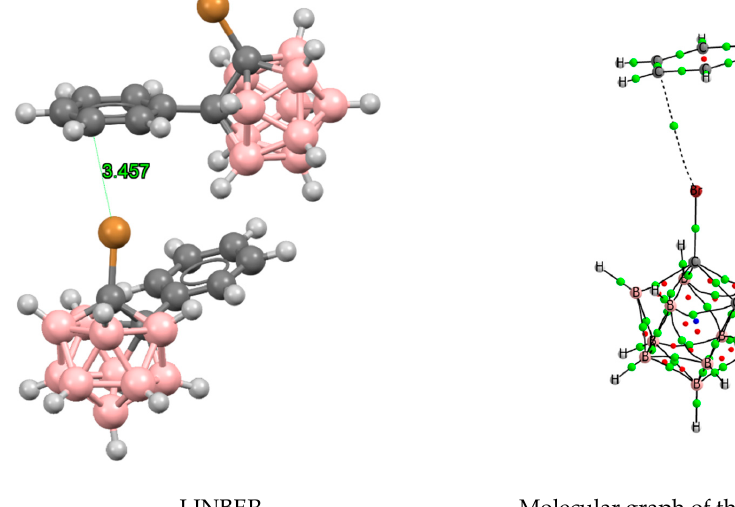
Figure 8. Crystal structure with refcode LINBEP and model calculated at MP2/aug-cc-pVDZ level. The shortest intermolecular Br-C distance in the LIMBEP structure is indicated in Å.